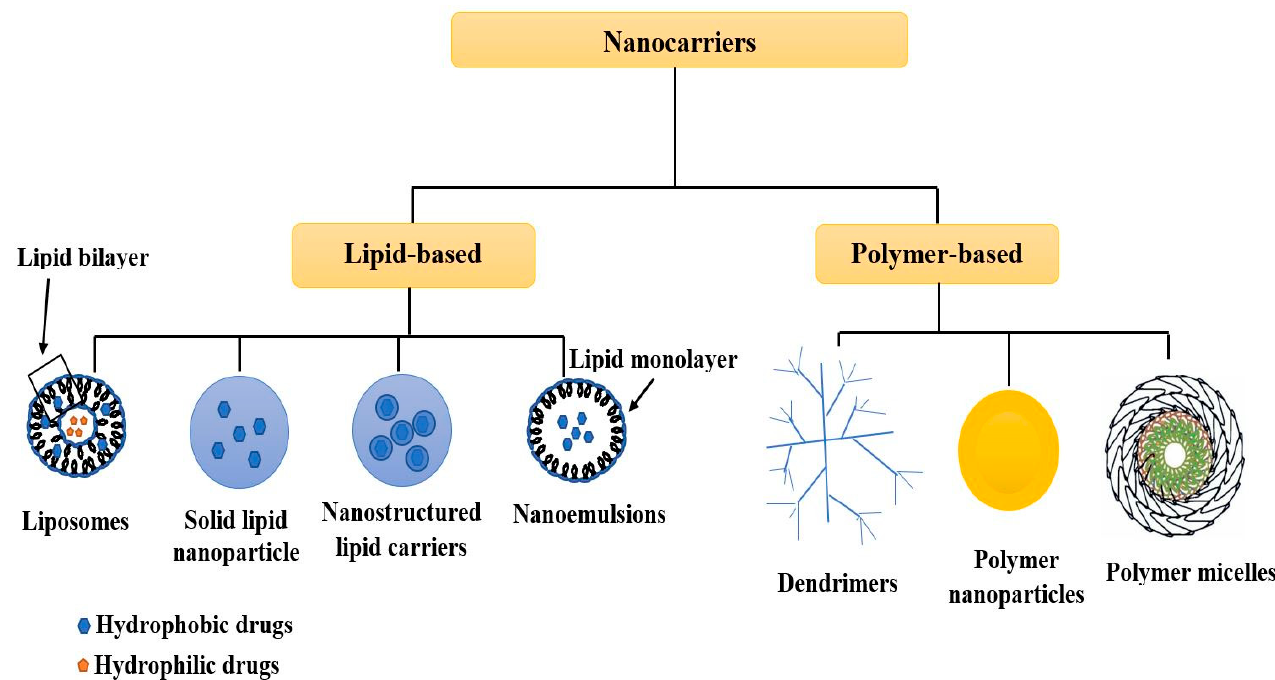
Figure 1. Schematic representation of different lipid-based and polymer-based nanocarriers.